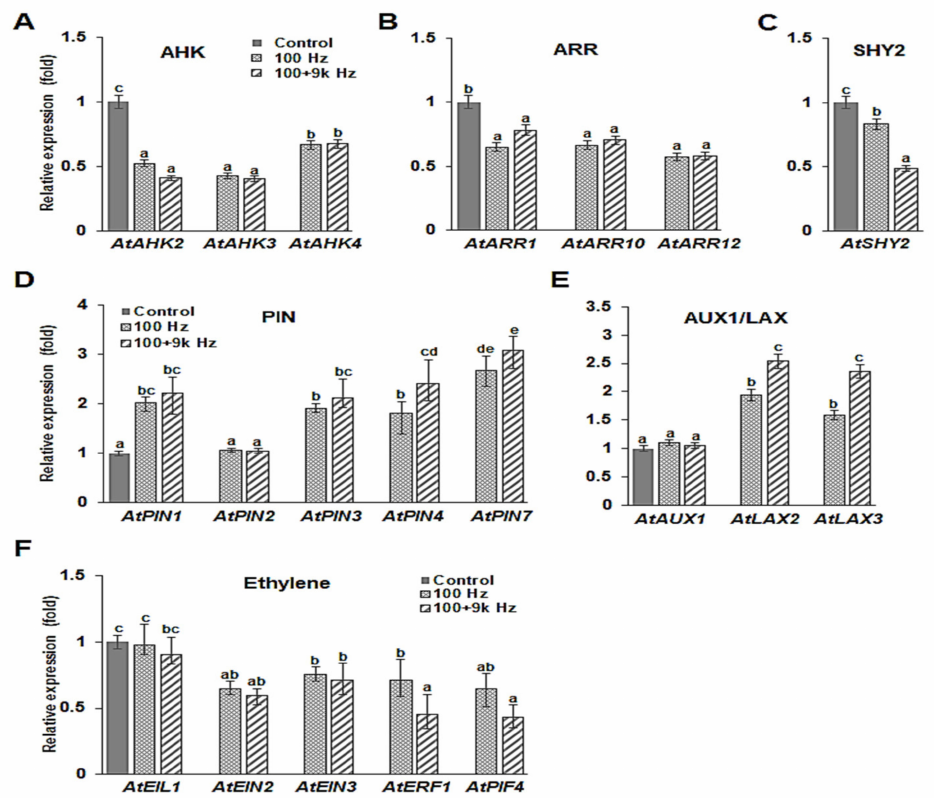
Figure 4. Effect of sound wave treatments on the expression of hormone-related genes in Arabidopsis roots. qRT-PCR was used to determine the expression levels of genes related to cytokinin (( A ), AHKs ; ( B ), ARRs ), auxin (( D ), PINs ; ( E ), AtAUX1 , AtLAX2 , and AtLAX3 ), and ethylene (( F ), AtEIL1 , AtEIN2 , AtEIN3 , AtERF1 , and AtPIF4 ) pathways, as well as AtSHY2 ( C ). The values were normalized to the value of the control. qRT-PCR error bars indicate the standard error of the mean of three biological replicates. Different letters above the bars indicate significantly different mean values ( p < 0.05) based on Duncan’s multiple range